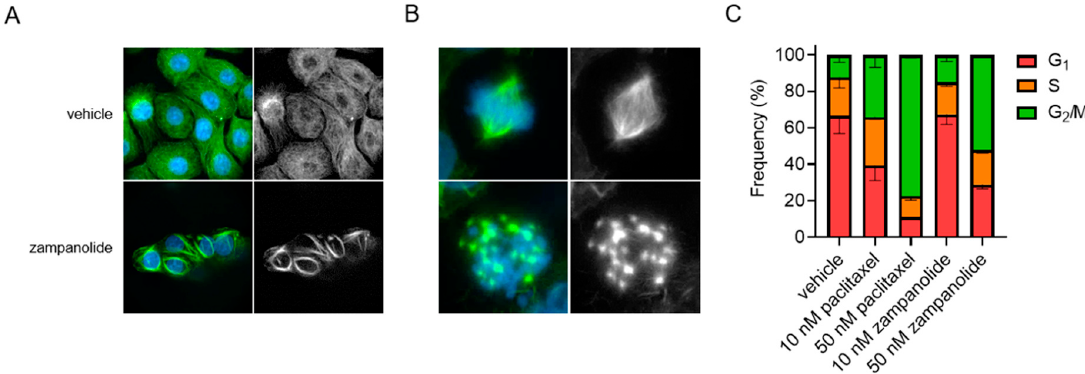
Figure 3. Microtubule stabilizing and antimitotic effects of zampanolide in TNBC cells. ( A , B ) Immunofluorescence images of microtubules in interphase ( A ) or mitotic ( B ) HCC1937 TNBC cells treated with zampanolide at 100 nM or vehicle control for 18 h. Microtubules are green and DAPI nuclear stain is blue. ( C ) MDA-MB-231 cells were treated for 20 h with 10 or 50 nM paclitaxel or zampanolide and cell cycle distribution evaluated by flow cytometry of cells stained with propidium iodide. N = 2 ± SEM.